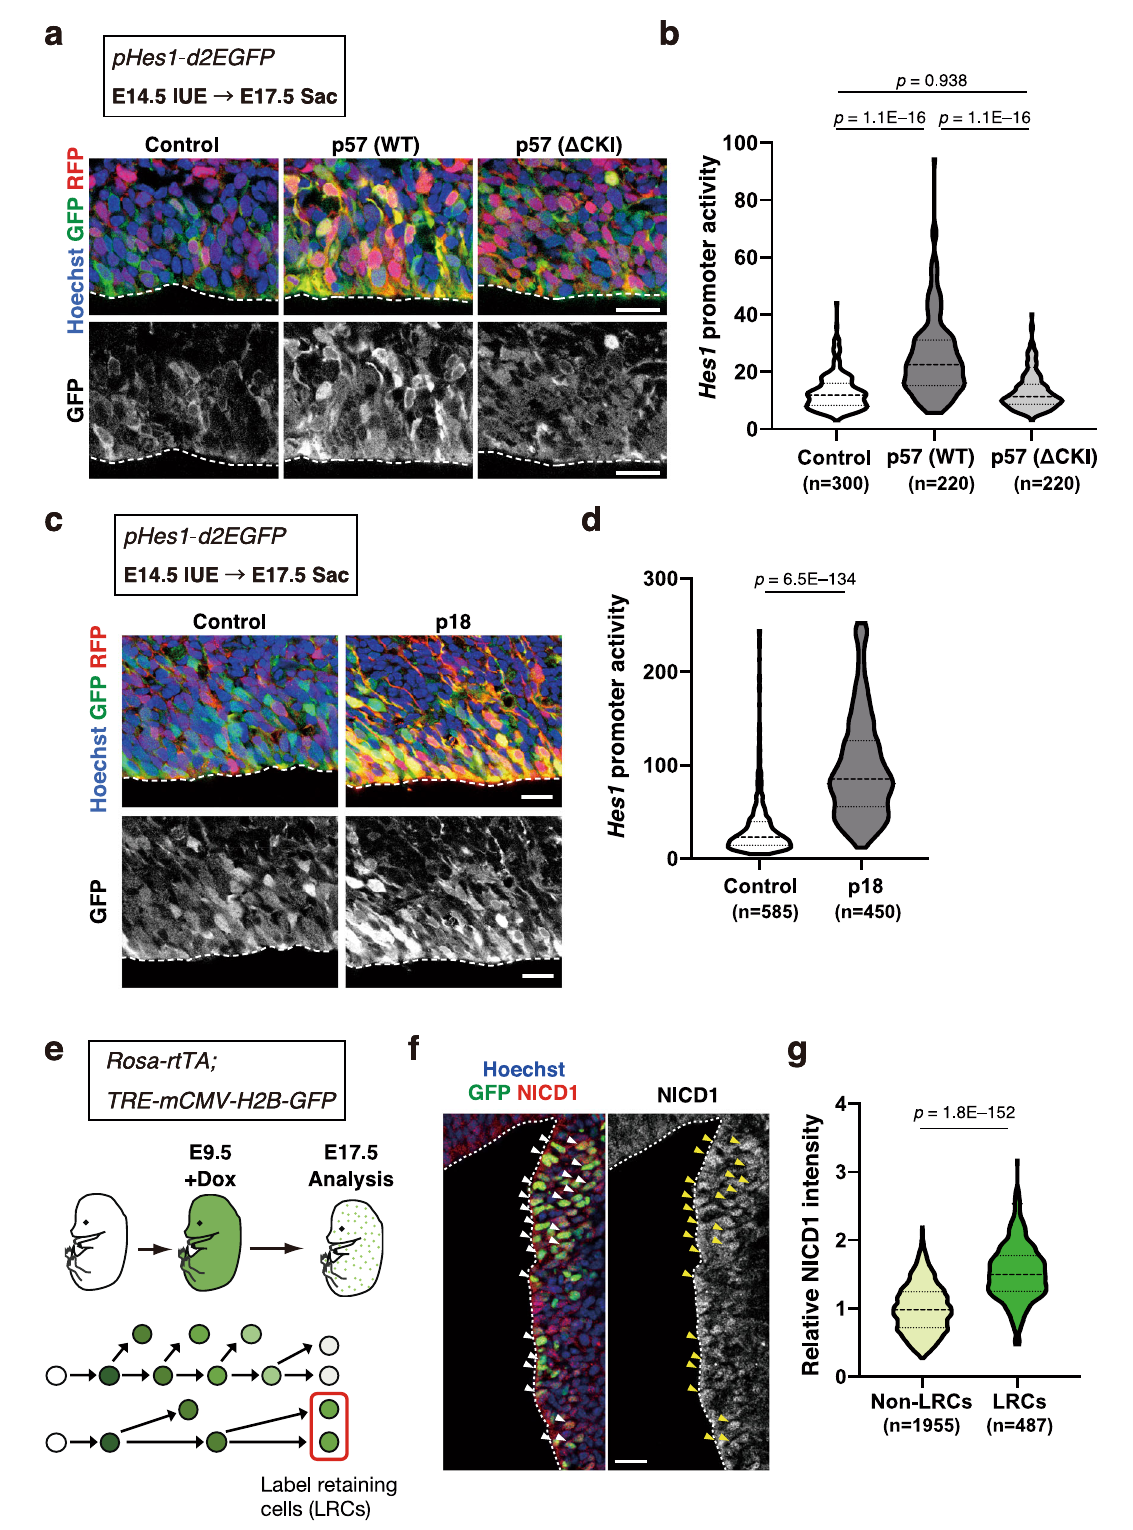
upregulated by p57 expression in embryonic NPCs include those related to lipid metabolism, steroid biosynthesis, lysosome, and cell adhesion (Fig. 1l and Supplementary Fig. 1i), which are also enriched in signature genes of quiescent adult NSCs but not those of adult ependymal cells 46 . These results indicate that p57 expression in embryonic NPCs is suf fi cient to skew their expression pro fi le close to that of quiescent adult